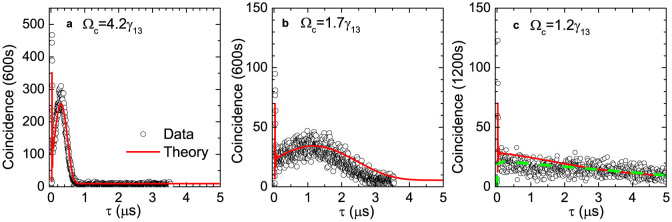
Accumulated coincidence counts measurements.(a), Ωc = 4.2γ13
(over 600 s); (b), Ωc = 1.7γ13
(over 600 s); (c) Ωc = 1.2γ13
(over 1200 s). black circles denote the experimental data, and the
red solid curve denotes the numerical results calculated from Eq.
1. The green dash line denotes the equation (3). Ωp
= 0.36γ13, α0L = 100.